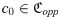
Connectivity kernel in 3D physical and color space.Left. W1 defined with r0 = 0 and c0 = 1. Right. W2 defined with r0 = 0 and c0 = .5. The color bar extends between −1 and 1, going from dark green (negative values, strong inhibition) to dark orange (positive values, strong excitation). We provide an interactive 3D animation of the connectivity kernels ω(r0, c0, ⋅, ⋅) for all values of
c0∈Copp
in
S1 File. For varying r0, the kernel is just spatially translated along r0. However, for varying c0, the positive and negative gaussian kernels in f follow c0 and −c0, collide when c0 goes through zero, then exchange of position when |c0| grows again.